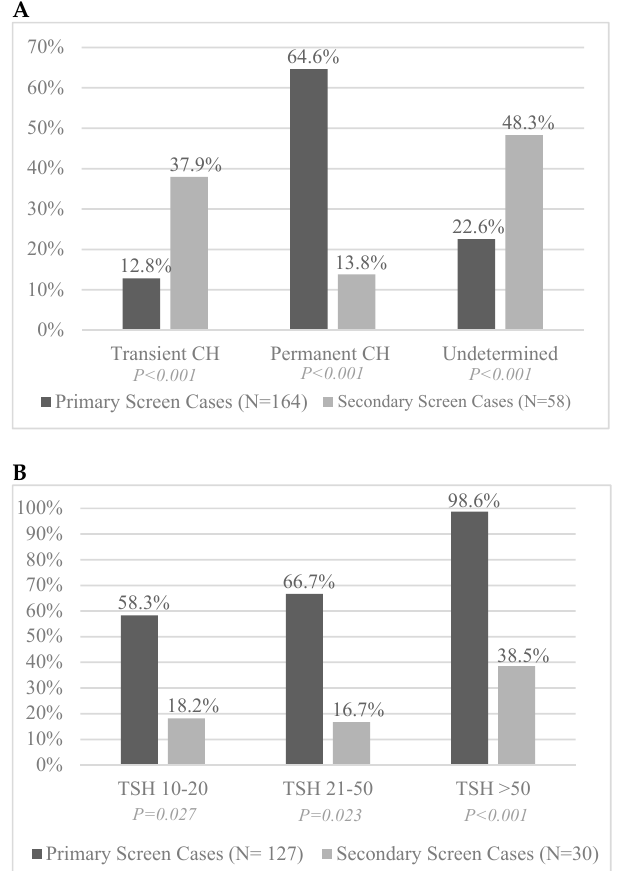
Figure 3. ( A ) Comparison of permanence of CH cases when diagnosed on primary vs. secondary screening. ( B ) Comparison of the likelihood of permanent CH in primary vs. secondary screen positive patients based on degree of TSH (mIU/L) elevation at time of diagnosis. Note: Includes only those patients where adequate data was able to establish potential permanence. Table 5. Presumed congenital hypothyroidism cases treated with levothyroxine in the first 60 days of life due to testing or judgement outside of the defined screening